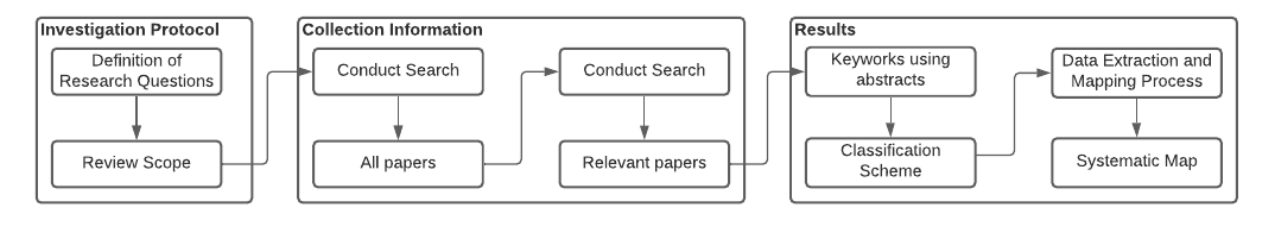
Figure 1. Process followed to obtain the systematic mapping review on AH